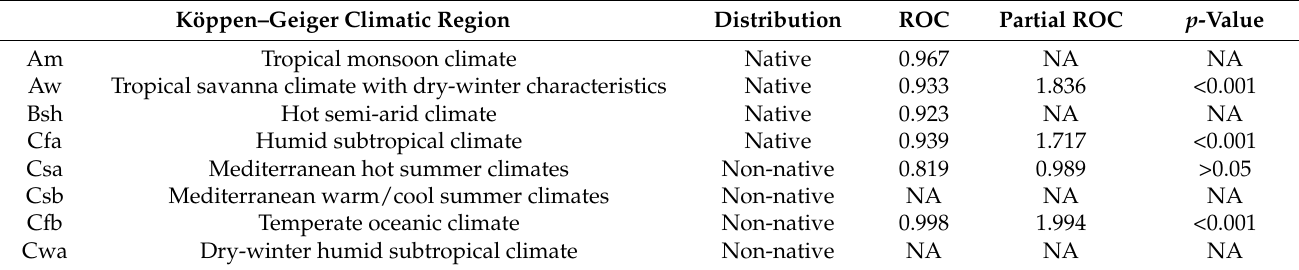
Table 5. AUC values for the ROC curve, average of the proportion values (ratio) for the partial ROC curve and their significance values (p-value) in each of the models. Köppen–Geiger climatic native regions: Tropical monsoon climate (Am), Tropical savanna climate with dry-winter characteristics (Aw) hot semi-arid climate (Bsh), and Humid subtropical climate (Cfa). Köppen–Geiger climatic non-native regions: Mediterranean hot summer climates (Csa), Mediterranean warm/cool summer climates (Csb), Temperate oceanic climate (Cfb), Dry-winter humid subtropical climate (Cwa). Köppen–Geiger Climatic Region Distribution ROC Partial ROC p -Value Am Tropical monsoon climate Native 0.967 NA NA Aw Tropical savanna climate with dry-winter characteristics Native 0.933 1.836 <0.001 Hot semi-arid climate Native